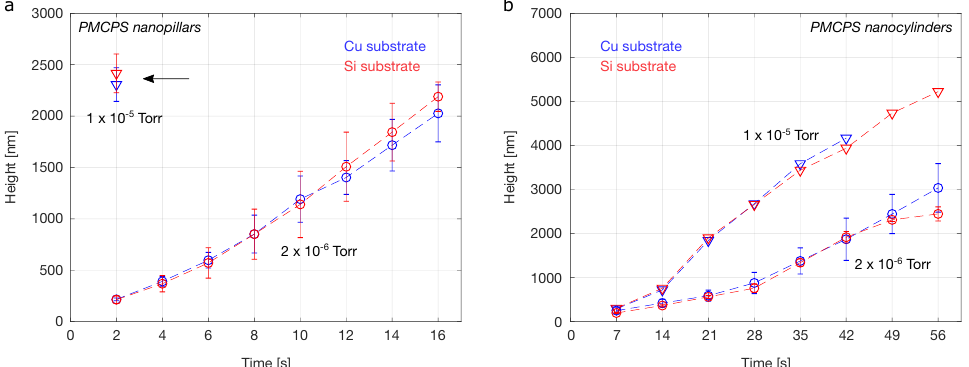
Figure 5. Plots of height versus deposition time for helium FIBID insulator nanostructures: ( a ) Nanopillars. ( b ) Nanocylinders. Data points for chamber pressures 2 × 10 − 6 Torr and 1 × 10 − 5 Torr are marked with circles and triangles, respectively. Blue represents data for the copper substrate and red shows data for the silicon substrate. The beam current was 1pA